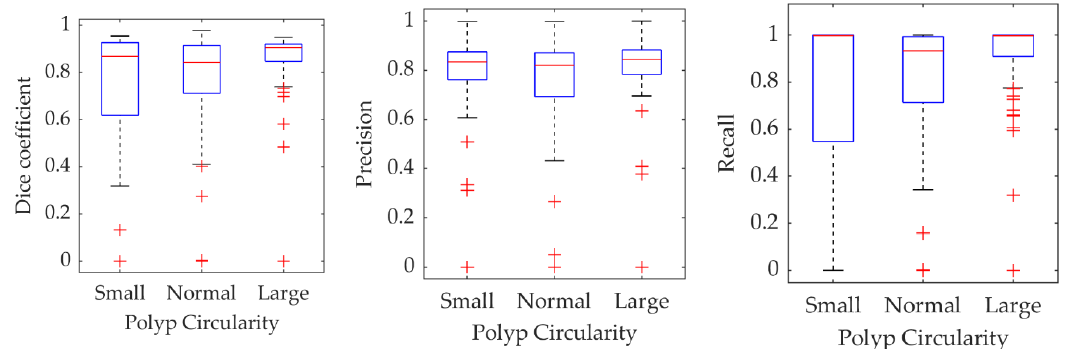
Figure 12. Statistics for different measures on the validation results obtained for the Dilated ResFCN network grouped as a function of the polyp circularity.